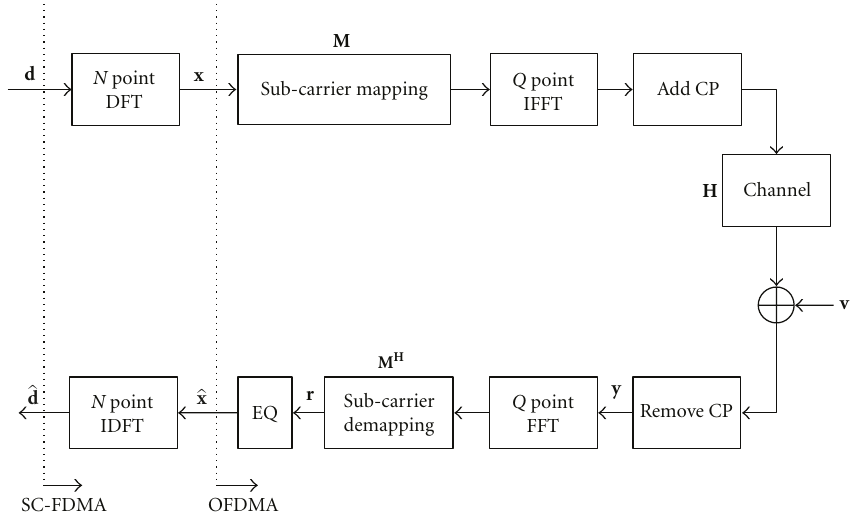
Figure 1: Block diagram of SC-FDMA systems and its relation to OFDMA